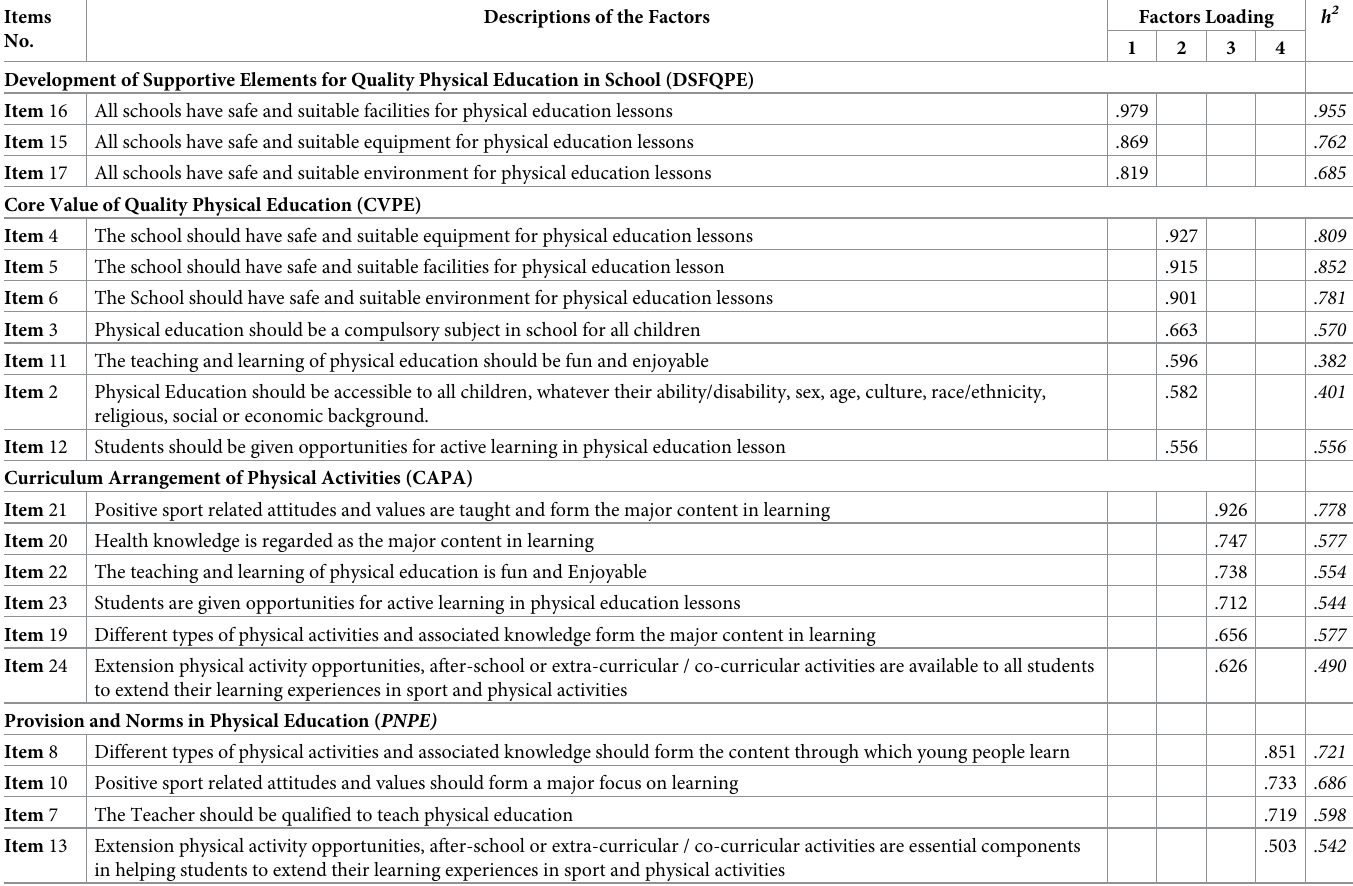
Descriptions of the